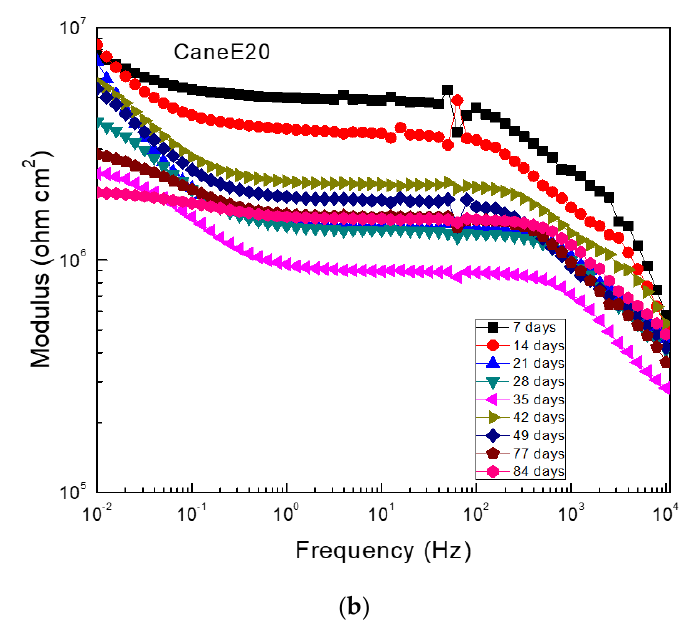
Figure 8. EIS data in the ( a ) Nyquist and ( b ) Bode formats for Al in the blend containing ethanol obtained from sugar cane.